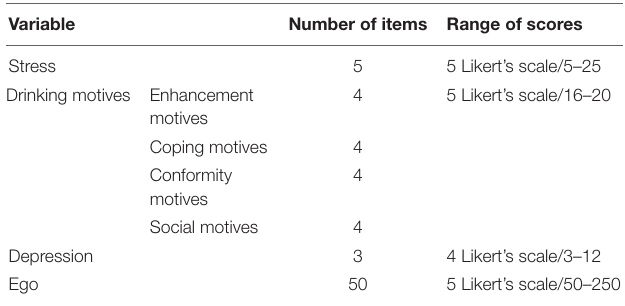
TABLE 1 | Number of items and range of scores for